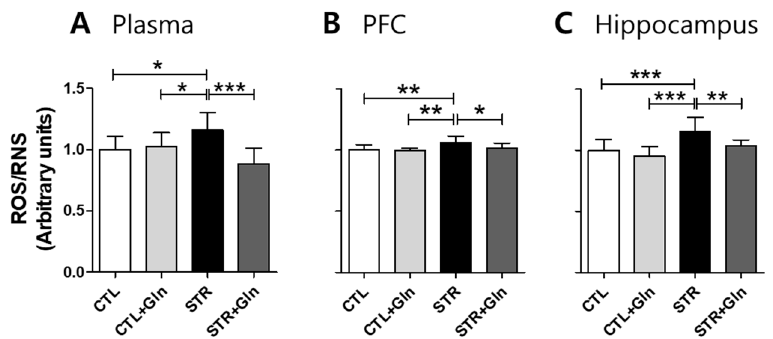
Figure 4. Glutamine (Gln) supplementation prevented chronic immobilization stress-induced reactive oxygen / nitrogen species (ROS / RNS) increase. Relative ROS / RNS levels in ( A ) plasma, ( B ) prefrontal cortex (PFC), and ( C ) hippocampus. The bar charts represent means ± SDs (arbitrary units). * p < 0.05, ** p < 0.01, and *** p < 0.001 values in a one-way analysis of variance followed by Newman–Keuls multiple-comparison tests. CTL, control ( n = 13); CTL + Gln, Gln-supplemented control ( n = 13); STR, stressed ( n = 12); STR + Gln, Gln-supplemented stressed ( n = 13).